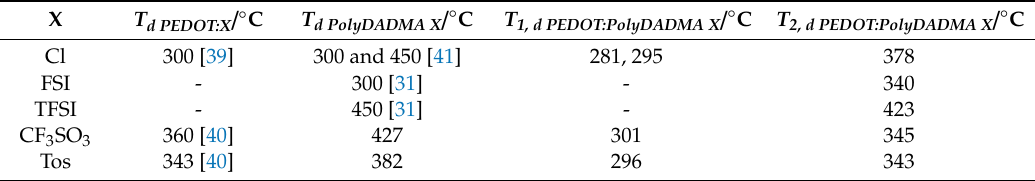
Table 2. Decomposition temperature of PEDOT:X, PolyDADMA X and PEDOT:PolyDADMA X, where T 1, d means the first step of decomposition and T 2, d means the second step of